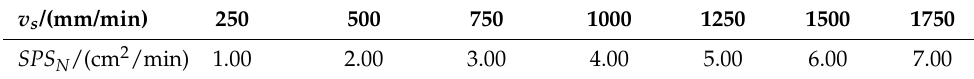
Table 4. The SPS N of dual-beam coupled nanosecond laser polishing. v s